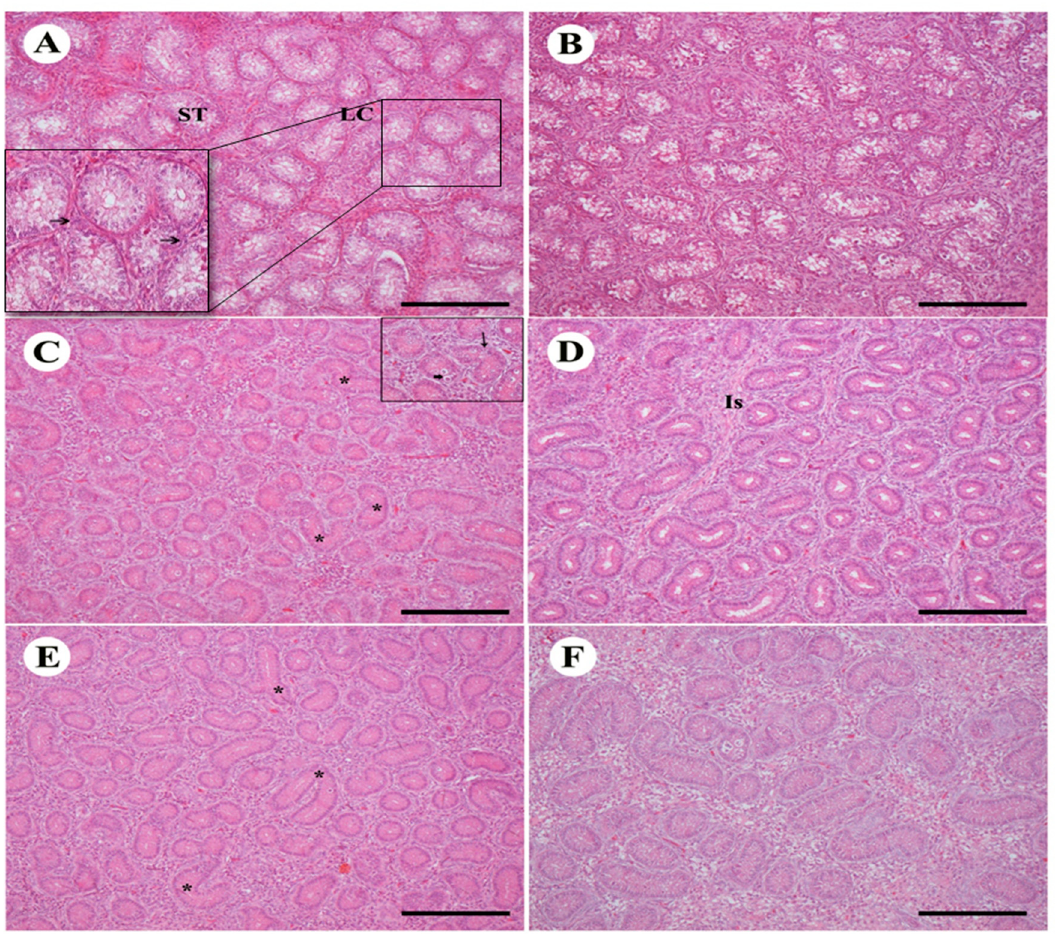
Figure 2. Effect of TAM treatment with different doses on testicular histology of two bird strains. ( A , B ): control testis of Avian48 A and Arbor Acer B shows normal structure of seminiferous tubules (ST) and Leydig cells (LC) in between. ( C , D ): testes treated with Tam10 showing different shapes of ST deformations in Avian48 C (*), giant cells (small arrow in the inset) and germinal epithelium differentiation (arrow), interstitial tissue Is, in Arbor Acres D. ( E , F ): testes treated with Tam20 with more deformities (*) Avian48 E , Arbor Acres F . H&E stain, scale bar = 100 µm.